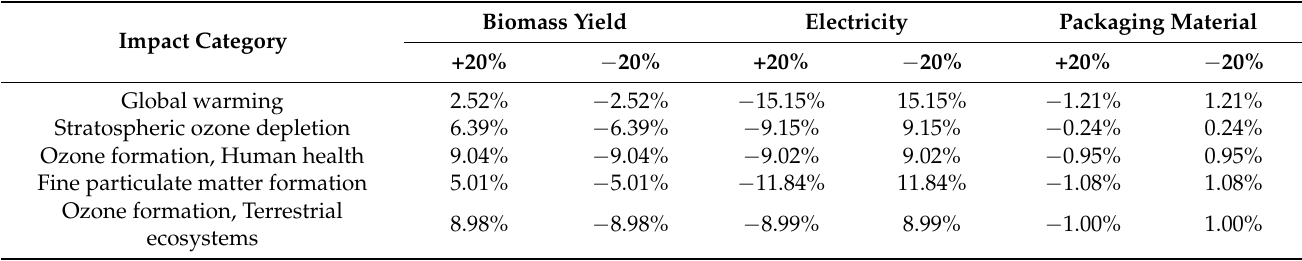
Table 5. Environmental impact of 1 ton of miscanthus biomass. Table 7. Sensitivity analysis results: Impact variation respect to the analysis with biomass yield and electricity and packaging material reported in Section 2.3—Inventory